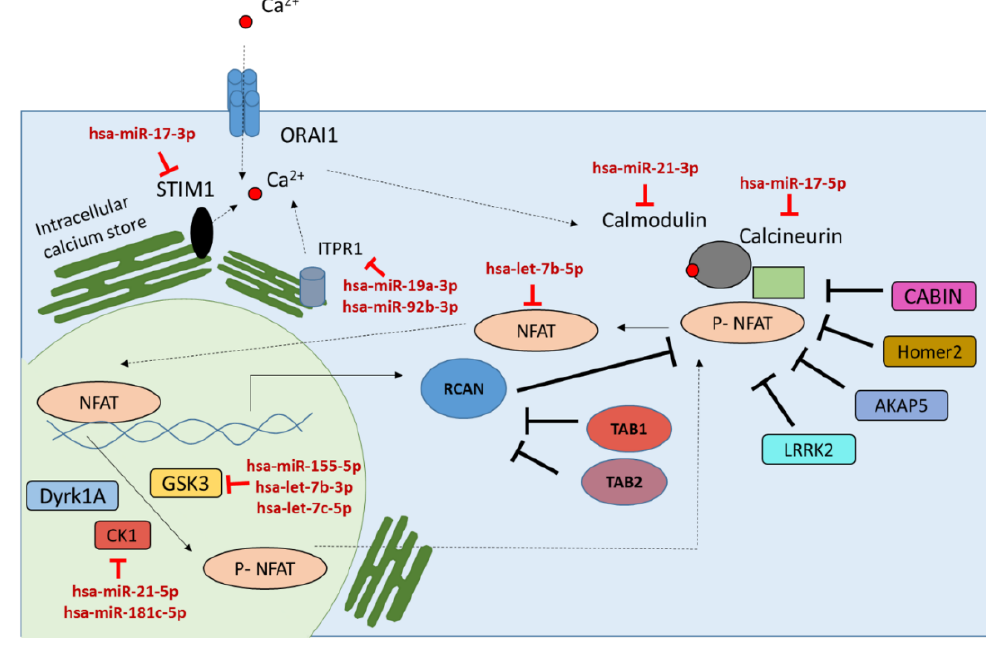
Figure 3. Schematic representation of the calcineurin/NFAT signaling pathway and the miRNAs involved in feedback loops to modulate the pathway activities. All the selected 23 genes associated with the calcineurin/NFAT signaling pathway in humans have miRNAs targeting those genes which are involved in feedback loops to regulate the calcineurin/NFAT signaling pathway.